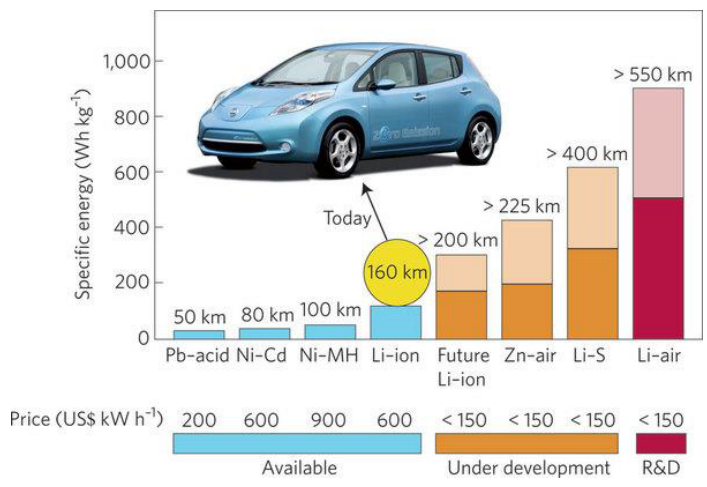
Figure 1. Practical specific energies of some rechargeable batteries, along with estimated driving distances and pack prices. Reprinted by permission from Macmillan Publishers Ltd: Nature Materials, Bruce et al. [6], copyright© 2011.